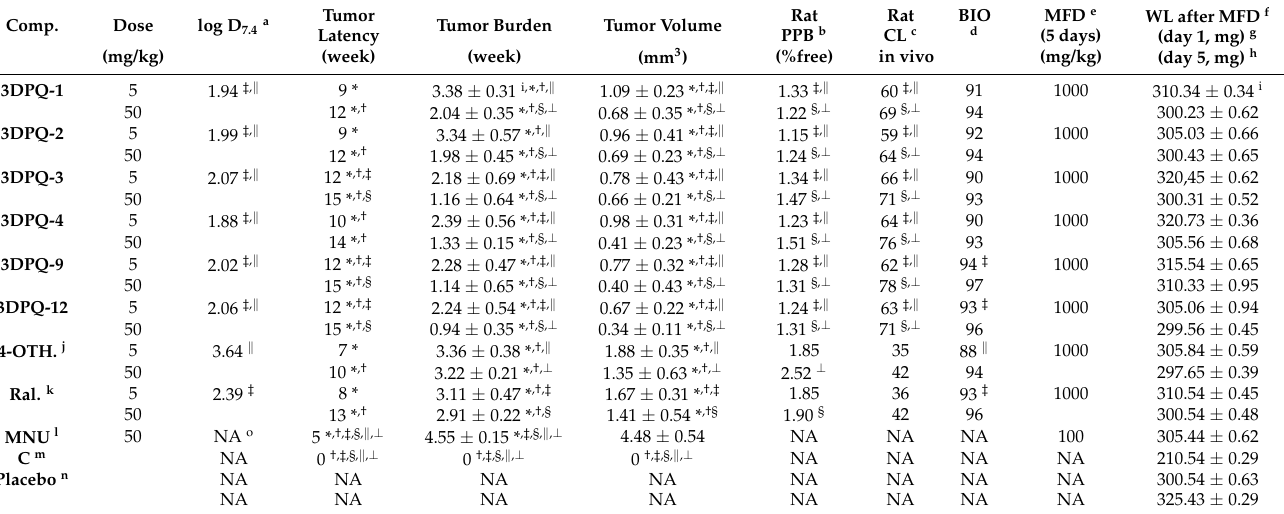
Table 11. Effects of synthesized compounds on mammary tumorigenesis.